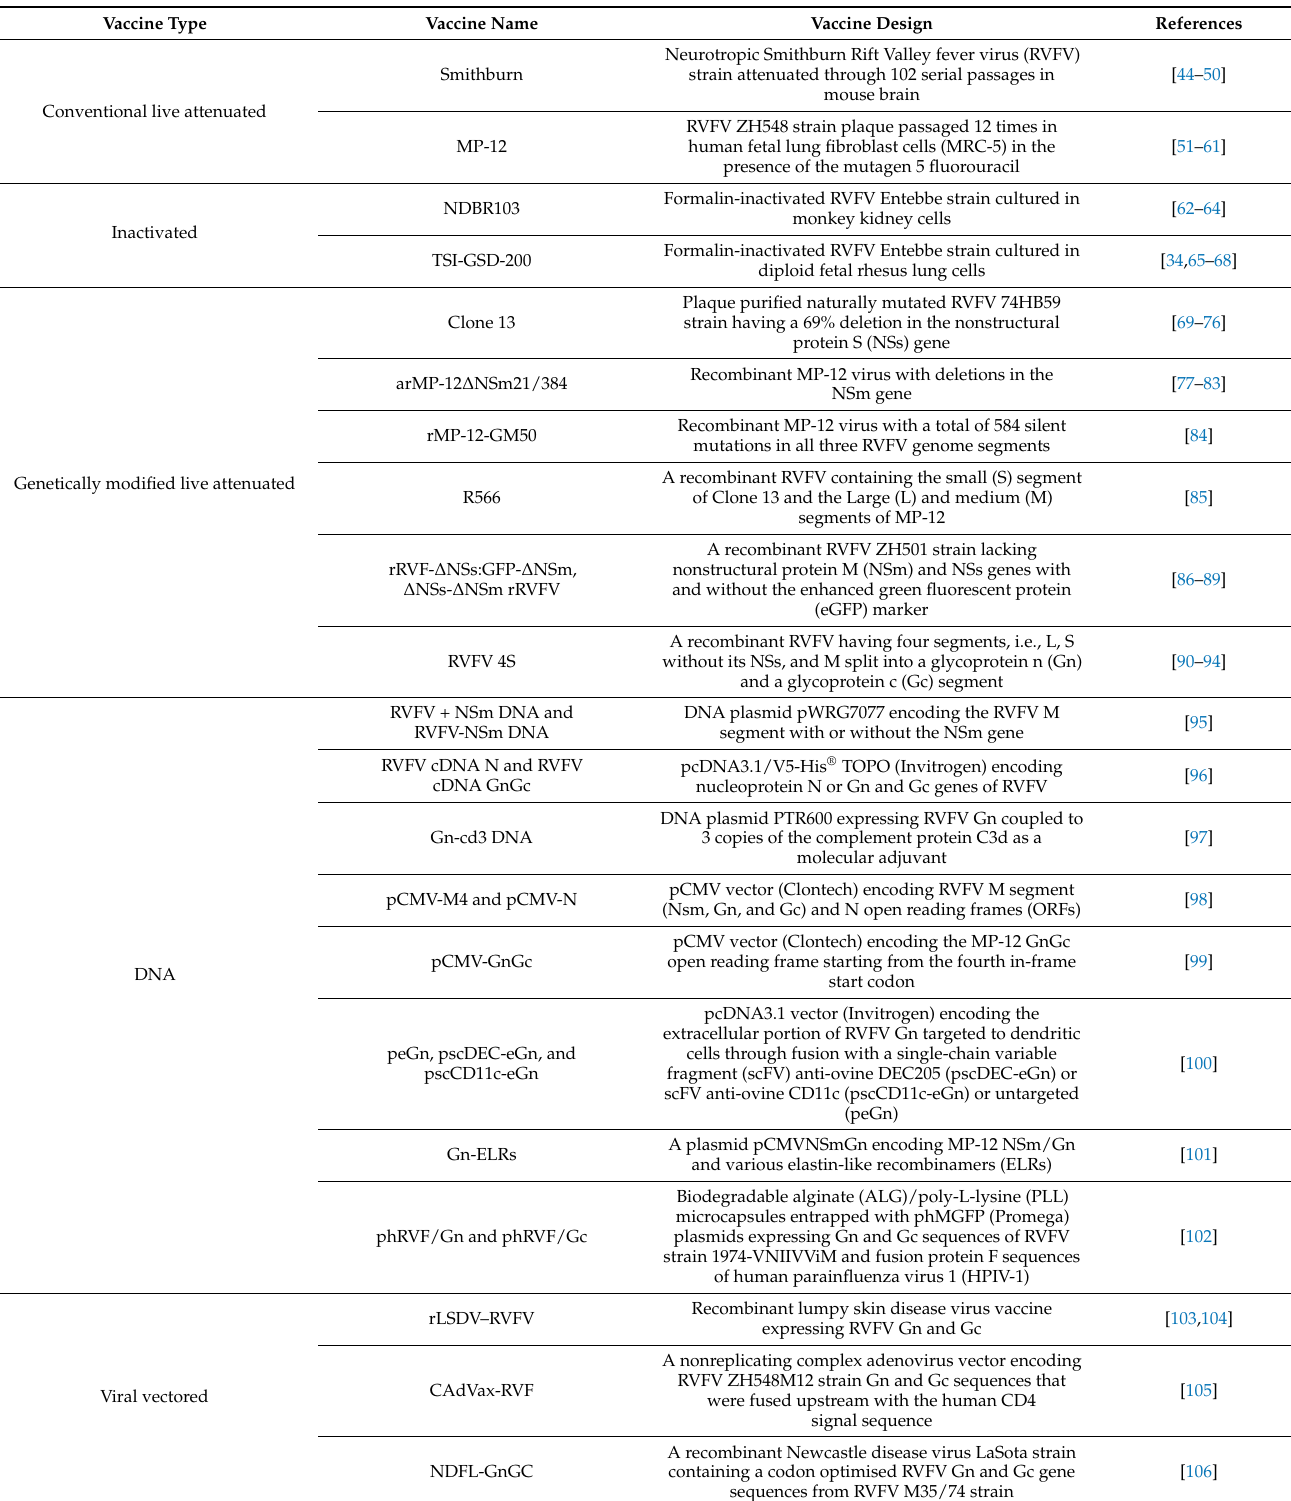
Table 1. Rift Valley fever vaccine development